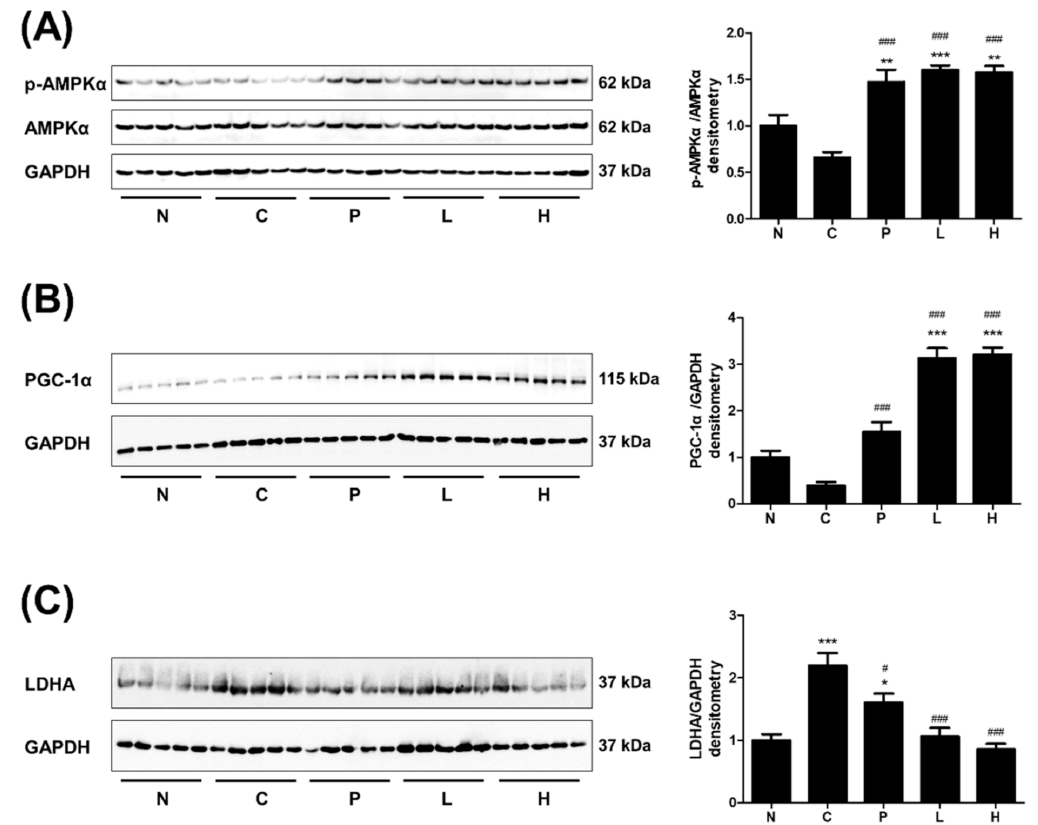
Figure 4. The administration of S. officinalis extract modulates physical performance-related factors in murine skeletal muscle. ( A – C ) The expressions of phospho-AMPK α (p-AMPK α ), phosphorylated-AMP-activated protein kinase alpha (AMPK α ), PGC-1 α , and lactate dehydrogenase A (LDHA) were evaluated in the quadriceps muscle tissue. GAPDH and AMPK α expressions were used as control. Densitometry was measured with protein expression. The results are shown as mean ± SEM. * p < 0.05, ** p < 0.01, and *** p < 0.001 compared with group N. # p < 0.05 and ### p < 0.001 compared with group C. N—normal, C—control, P—positive control, L—low-dose S. officinalis , H—high-dose S. officinalis